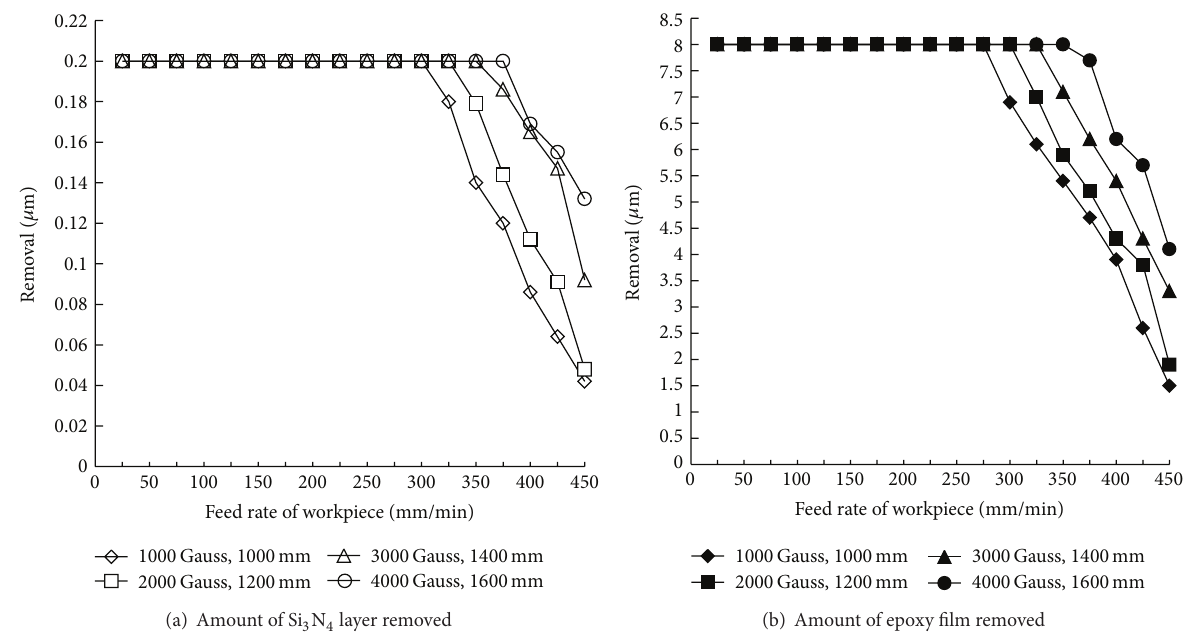
Figure 5: Amount of Si 3 N 4 layer and epoxy film removed using different combinations of magnetic field strength and distance between the two magnets (phosphoric acid 25% wt, NaNO 3 15%wt, PO4-3-P 5% wt, 60 ∘ C, 40 L/min, continuous DC, 150A, 80V, 100kHZ/150W, shift 800 rpm, and tool 900 rpm).